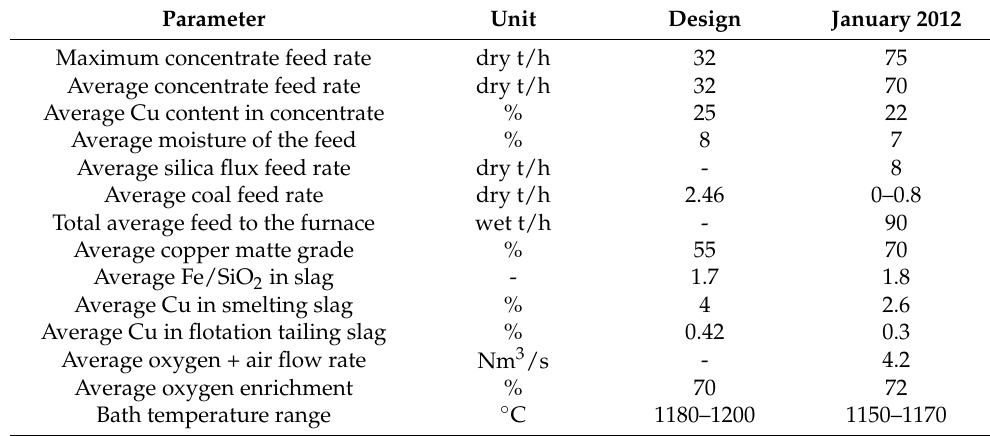
Table 2. Typical process parameters for Fangyuan smelting plant in January 2012. Data derived from [7]. Parameter Unit